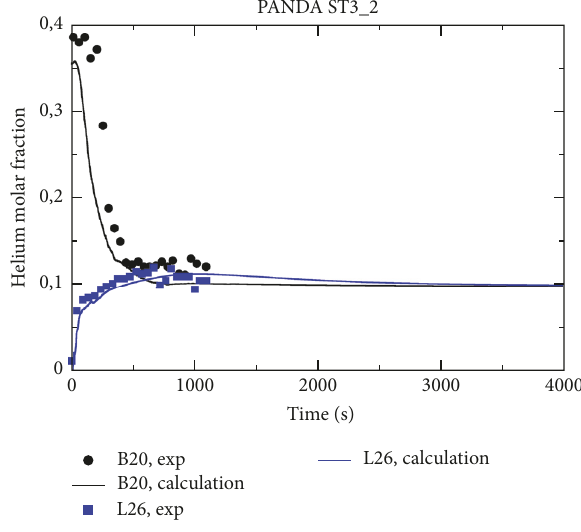
Figure 29: Helium molar fraction in Vessel-1.